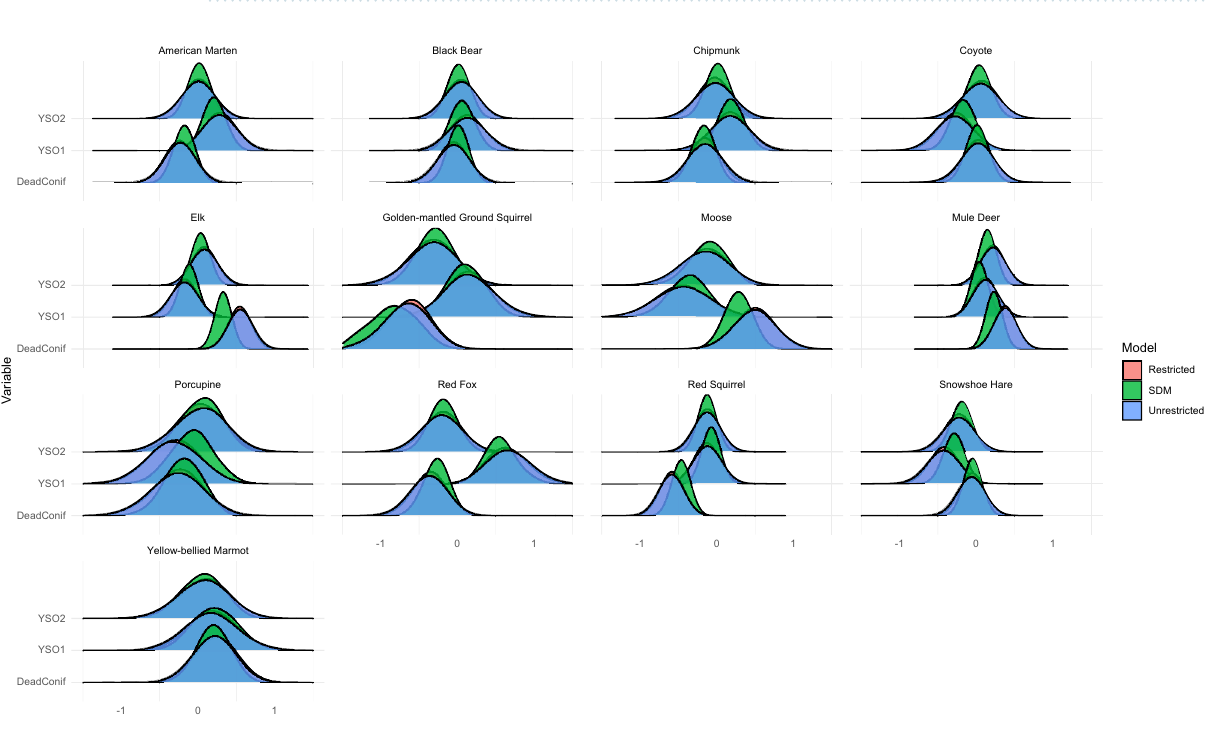
Figure 3. Marginal posterior distributions of infestation regression parameters. Posterior distributions shown are from the Royle-Nichols SDM, unrestricted JSDM, and restricted JSDM. DeadConif is the overstory mortality percentage, a proxy for severity of bark beetle infestation. YSO1 is the linear effect of the number of years since a site was infested with bark beetles. YSO2 is the quadratic effect. Figure created in R 4.1.2 62